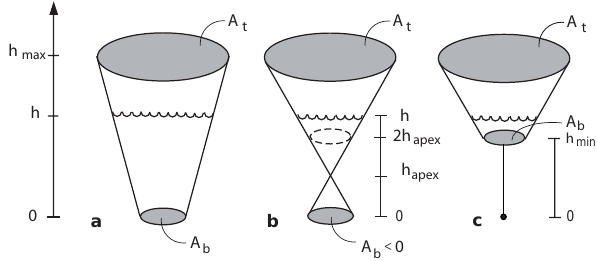
Fig. 3. The geometry of the moulin element, with water filling height h , top ( A t ) and bottom ( A b ) cross-sectional area. (a) A b > 0; (b) A b < 0, in which case the apex of the cone has height h apex and the volume below the apex is negative; (c) equivalent moulin geometry to (b) provided h does not fall below h min = 2 h apex